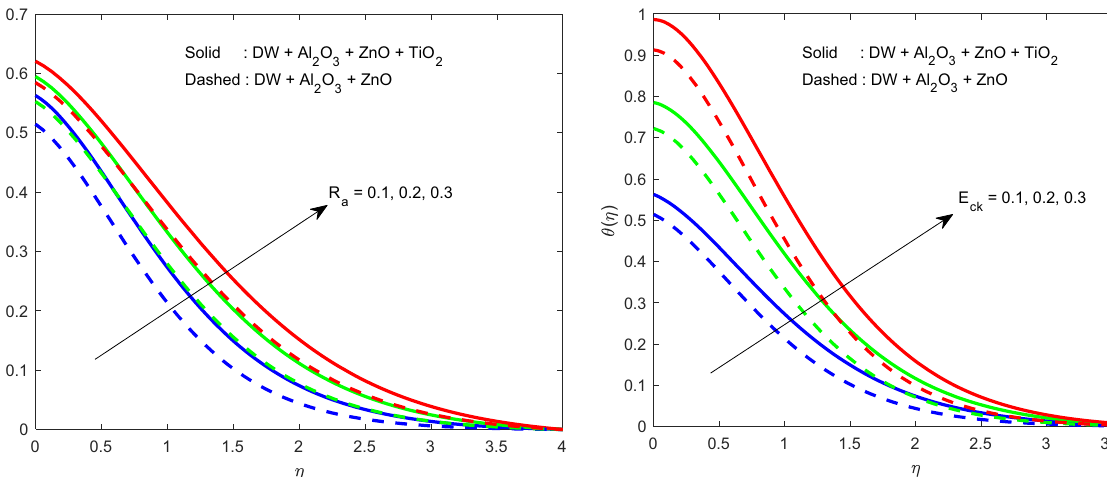
Figure 8: Increasing e ff ects of E ck on θ ( η )